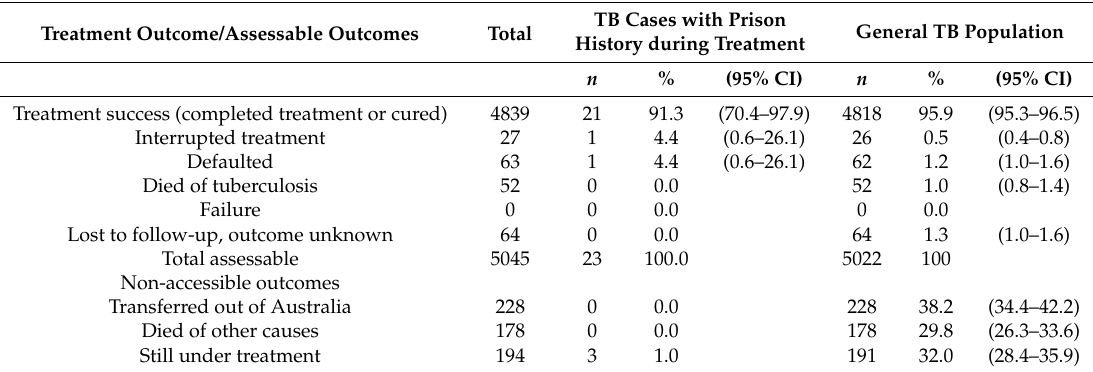
Table 2. Treatment